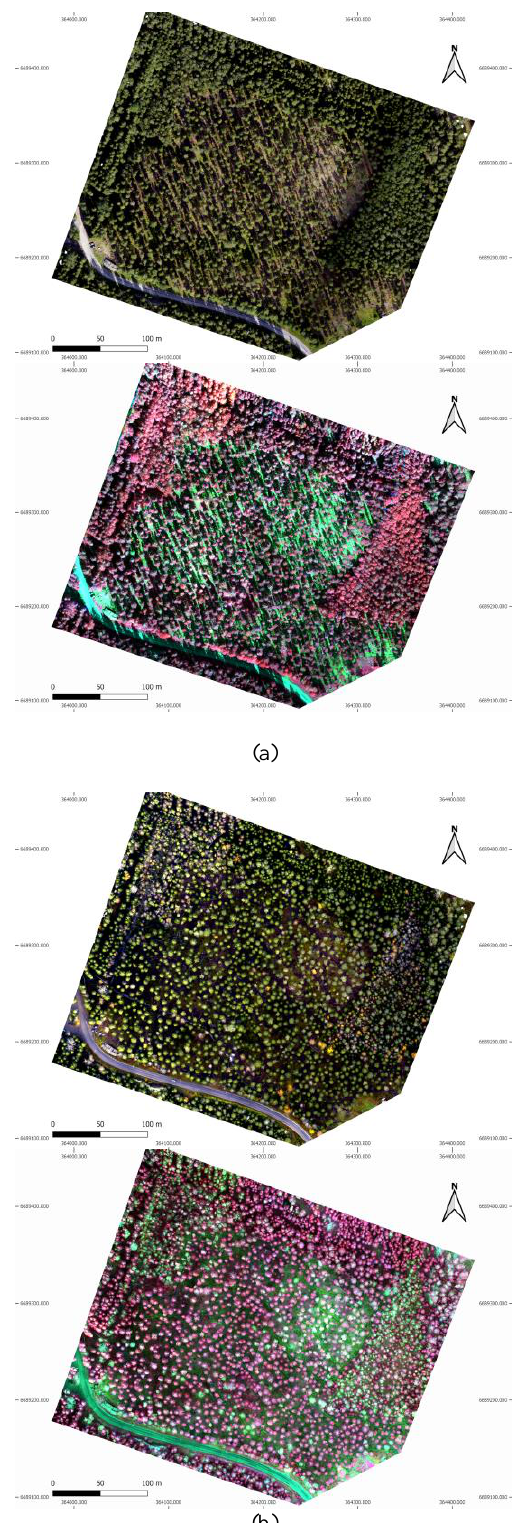
Figure 2. RGB and hyperspectral color-infrared mosaics from the test area (a) August 15 and (b) October